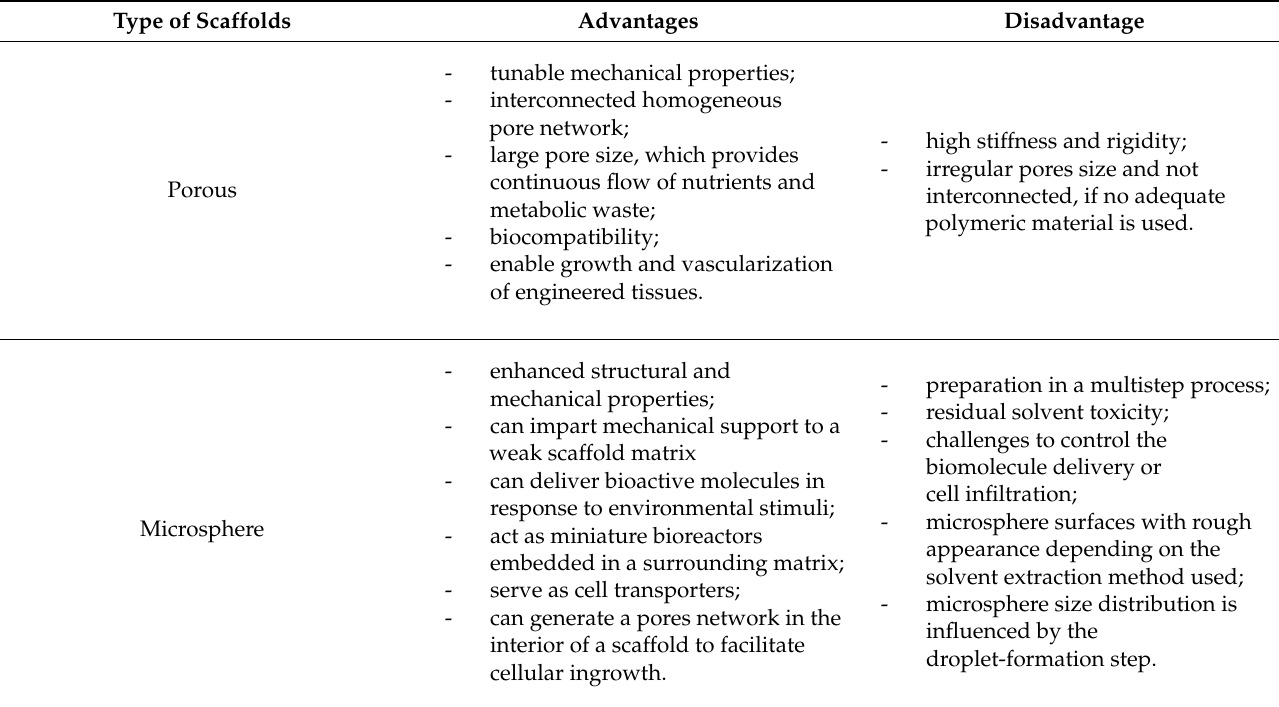
Table 1. Comparative analysis of porous, microsphere, hydrogel and fibrous scaffolds. Type of